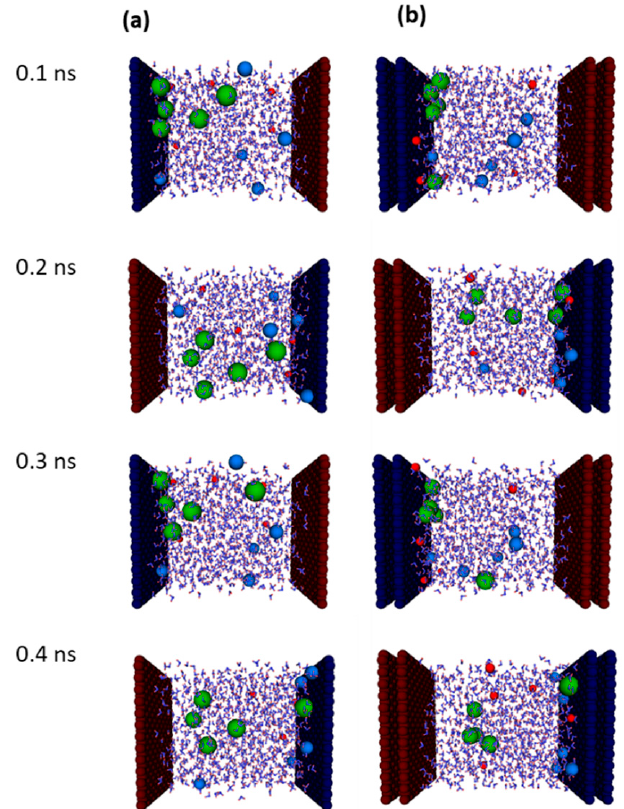
Figure 6. Snapshots of Li, Na, and K aqueous electrolytes between ( a ) single-layer graphene and ( b ) bilayer graphene. Li, Na, and K ions are represented by red, blue, and green spheres, respectively. H 2 O is illustrated by blue and red sticks. Graphene walls with positive and negative partial charges are shown by dark red and blue spheres representing carbon atoms, respectively.